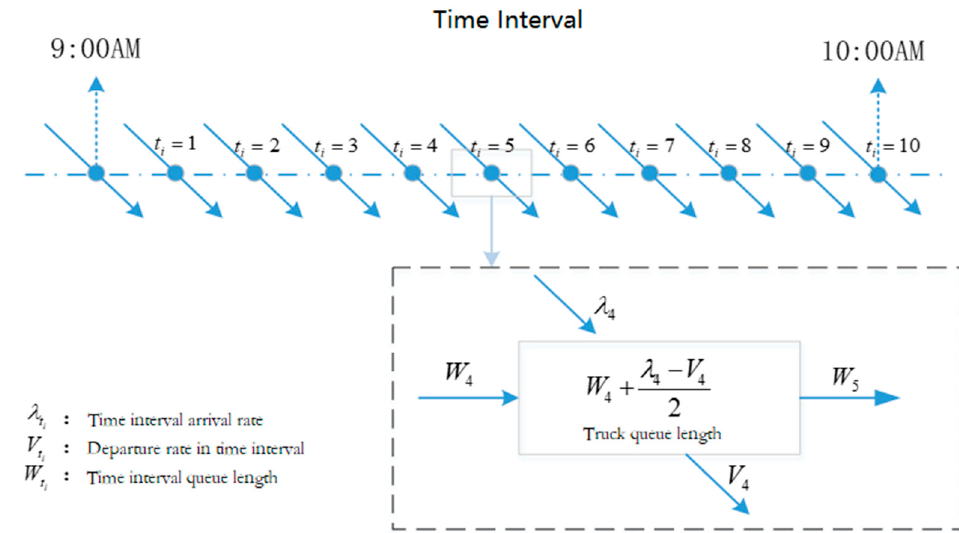
Figure 1. PSFFA description.